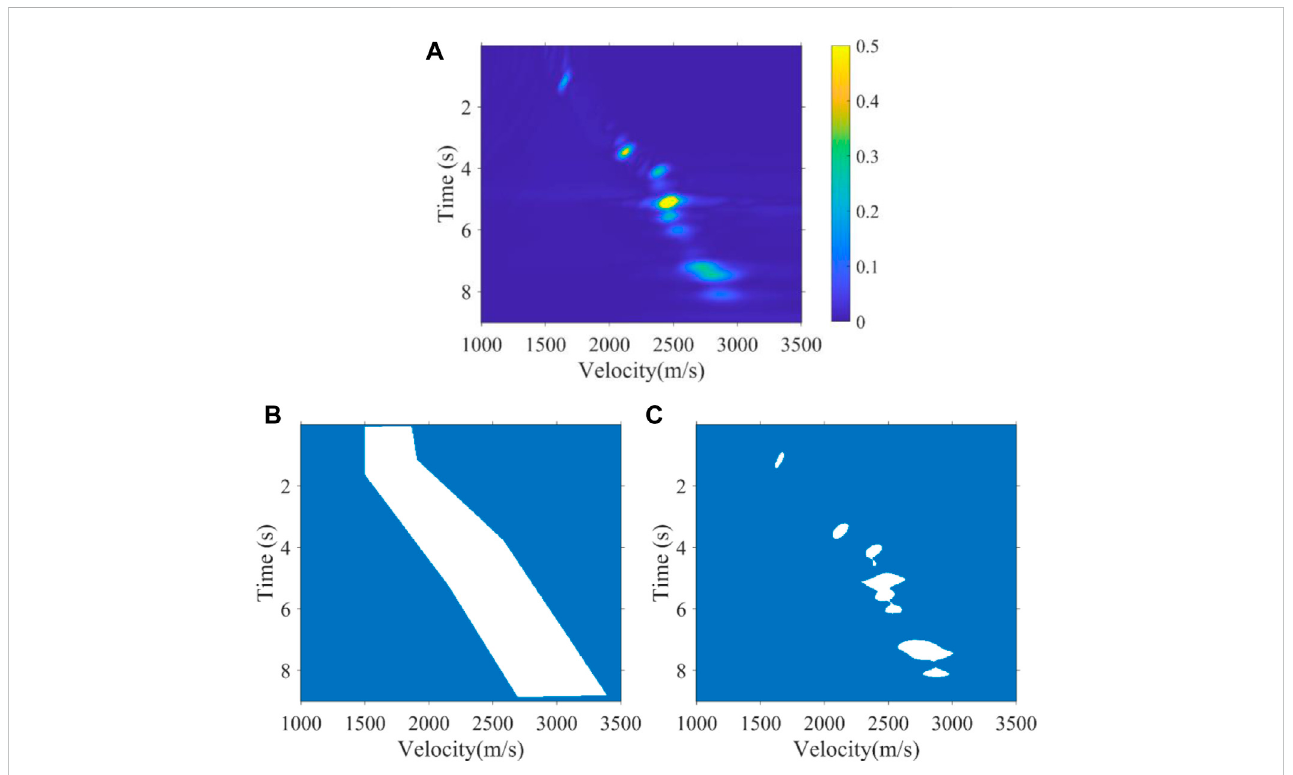
FIGURE 2 (A) 40th velocity spectrum with a high signal-to-noise ratio of the Marmuosi model, (B) expert experience constraint band, and (C) segmentation